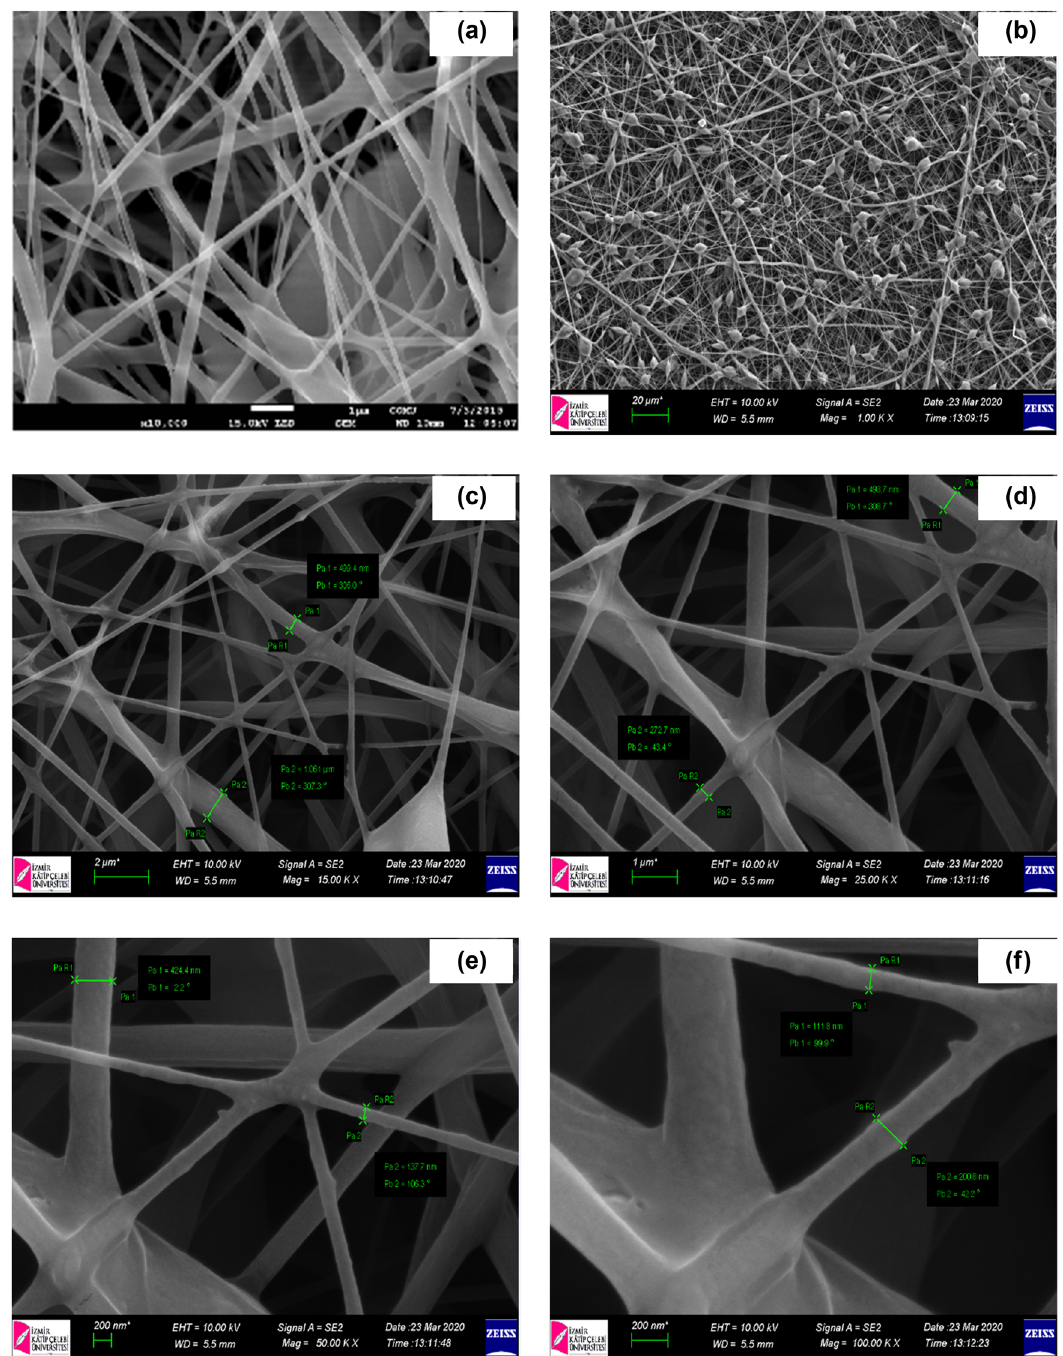
Figure 1: SEM images of the nano fi bers ( a ) neat PLA, ( b – f ) PLA - CUP nano fi